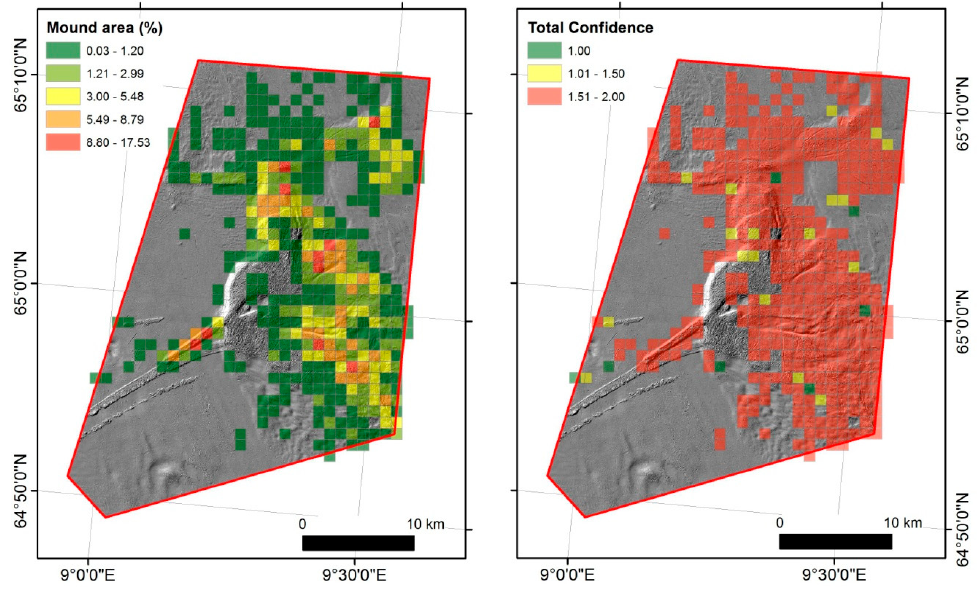
Figure 6. Left —Carbonate mound area per 1 km 2 block expressed as percentage of mound area per block. Right —Average total confidence per 1 km 2 block. Only blocks that were occupied by at least one carbonate mound are shown.